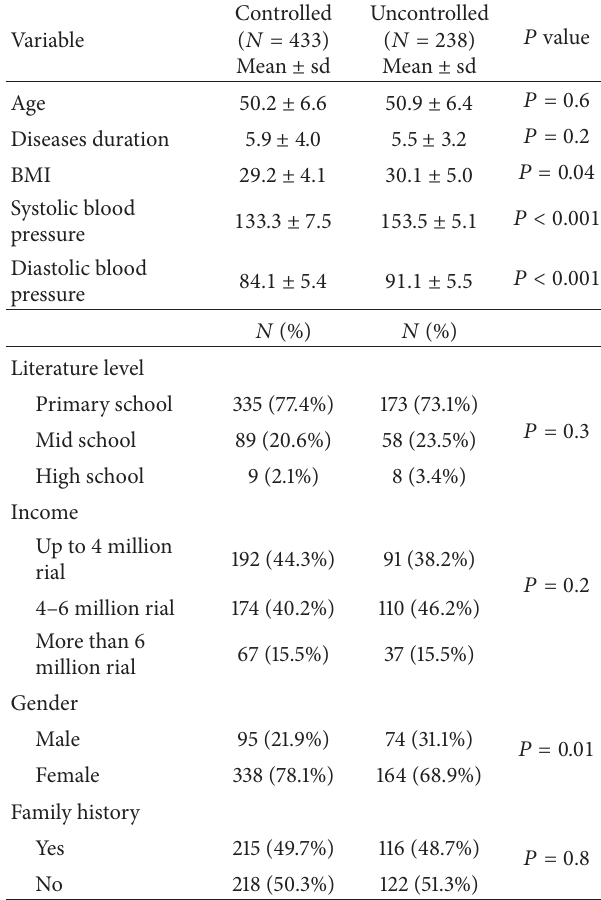
Table 1: Demographic characteristic of controlled 1 and uncon- trolled 2 hypertensive